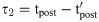
Framework set-up.A. A network of excitatory neurons (light blue triangles) fire stochastically, while their activity is driven by unstructured external input (red arrows) and modulated by a population of inhibitory neurons (yellow circles). Excitatory connections among the neurons can be weak (gray dashed arrows) or strong (black solid arrows), unidirectional or bidirectional. B. Cumulants of the spike trains (see Eq 1). The second-order cumulants Cij, Cii and Cjj are calculated based on the time difference between a pair of spikes (cross-covariance in green; auto-covariances in orange/red). The third-order cumulant Kij is calculated based on the time differences between three spikes (purple). The spike triplets can be two post- and one presynaptic spikes, or one post- and two presynaptic spikes. The time differences are: τ1 between a presynaptic spike and a postsynaptic spike, τ2 between different postsynaptic spikes and τ3 between different presynaptic spikes. C. STDP-induced plasticity by pairs and triplets of spikes. Left: An example of a classical pair-based STDP rule, with a learning window denoted by L2. Potentiation is triggered by a postsynaptic following a presynaptic spike (τ1 = tpost − tpre > 0), whereas if a presynaptic spike follows a postsynaptic spike (τ1 = tpost − tpre < 0), depression is induced. The total potentiation (depression) is given by the red (blue) area under the curve. Right: Examples of triplet STDP rules denoted by L3,y and L3,x. Potentiation (red) and depression (blue) are given by triplets of spikes: post-pre-post with a time difference τ2=tpost−tpost′, and pre-post-pre with a time difference τ3=tpre−tpre′, respectively. D. Minimal triplet STDP rule where potentiation depends on triplets of spikes L3 and depression on pairs of spikes L2.